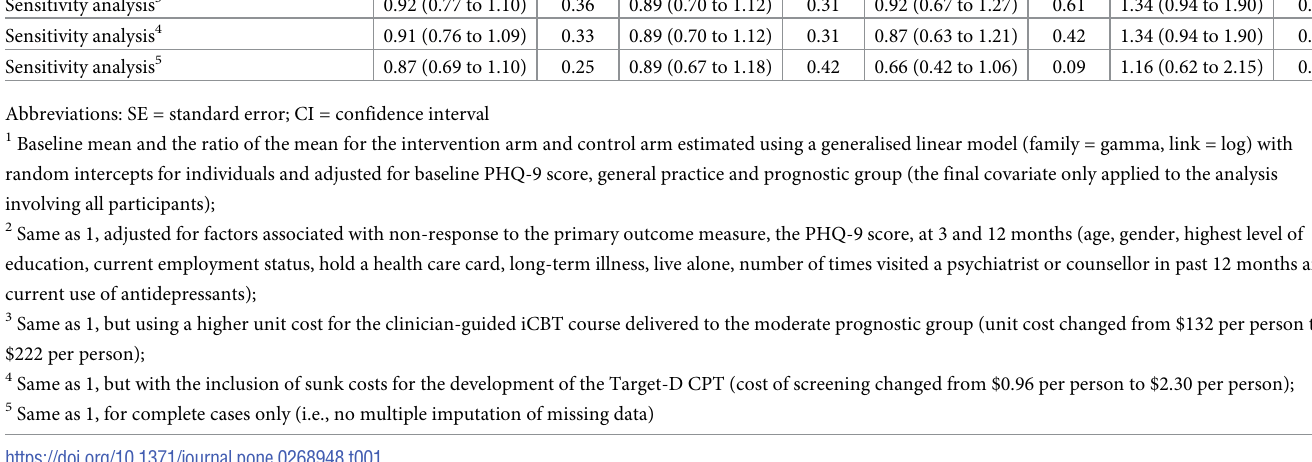
All participants p-value Minimal/mild p-value Moderate p-value Severe (n = 223) (n = 1,868) (n = 1,357) (n = 288)